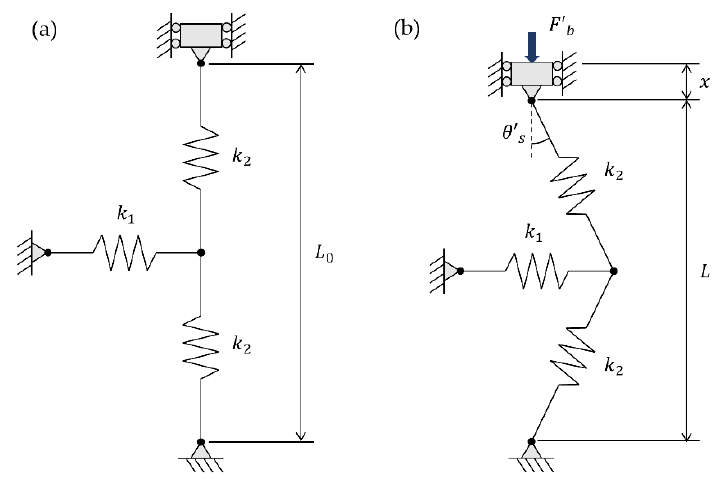
Figure 4. Parameters of equivalent spring system in the free strain ( a ) and in post-buckling state ( b ).